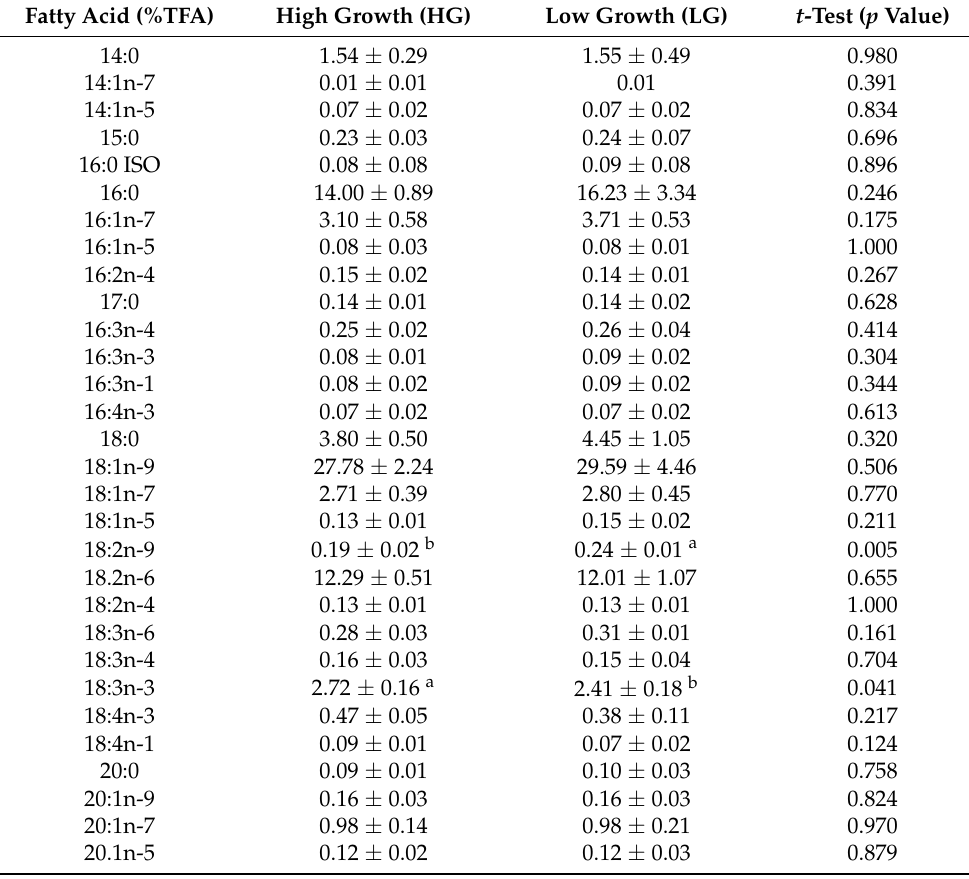
Table 8. Fatty acid composition (% total fatty acids) of eggs of gilthead sea bream broodstock selected for high (HG) or low (LG) growth before feeding the experimental diets (HG, n = 2; LG, n = 2). Fatty Acid (%TFA) High Growth (HG) Low Growth